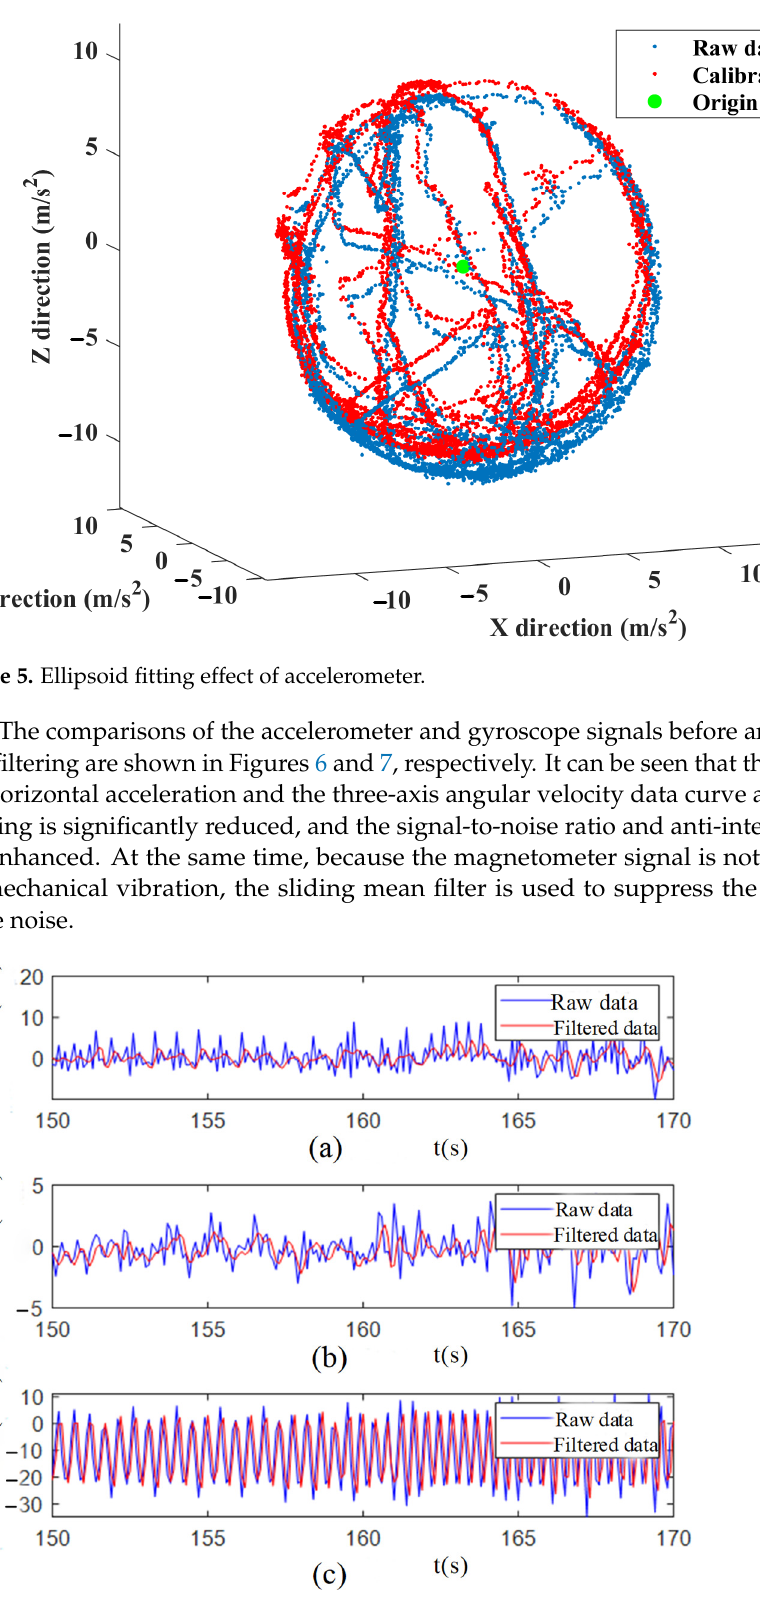
Figure 6. Comparison diagram of accelerometer signal before and after calibration and filtering. ( a ) Specific acceleration in X-axis. ( b ) Specific acceleration in Y-axis. ( c ) Specific acceleration in Z- axis.